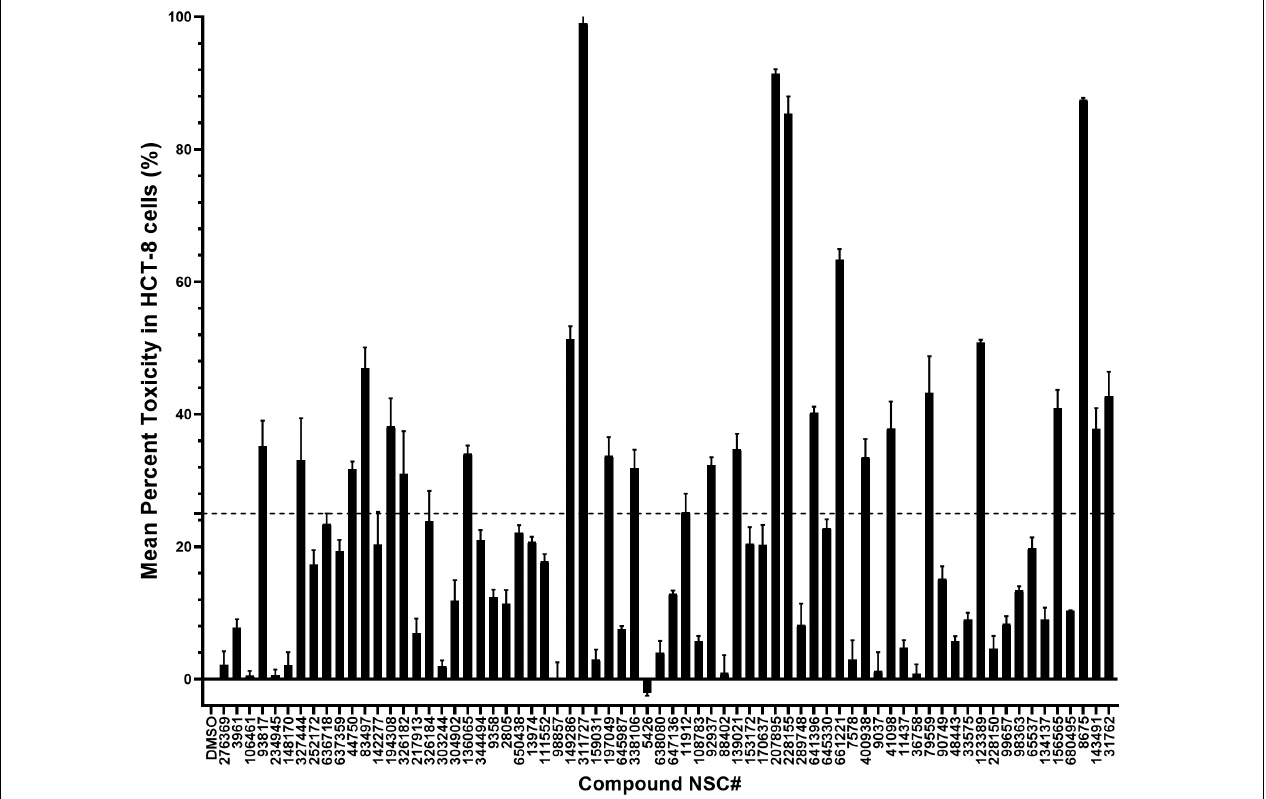
FIGURE 3 | Mean percent toxicity (MPT) values of test compounds in HCT-8 cells. Individually reconstituted compounds were incubated with uninfected HCT-8 cells for 24 h at a final concentration of 50 µ M. Control wells without chemical compound, but in which equivalent volumes of DMSO (chemical compound solvent) were added were also set up. Following 24 h of culture, a colorimetric assay using the cell proliferation reagent WST-1 was used for the quantification of cell viability. The MPT value of each compound was derived by dividing the difference in absorbance between the compound-treated cells and the DMSO-treated cells by the absorbance from the DMSO- treated cells and multiplying the product by 100. The baseline MPT of 0 was for the reaction without compound, but with an equivalent volume of DMSO used to reconstitute the compounds. Each reaction was performed in triplicate, and the data shown represent the mean of three independent experiments. Bars represent standard errors of the mean